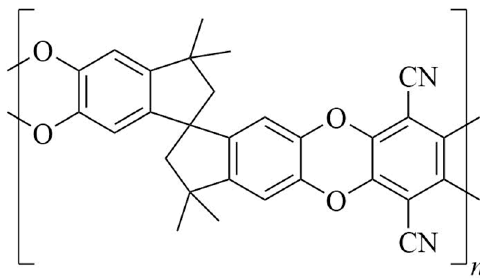
Figure 1. Chemical structure of PIM-1.